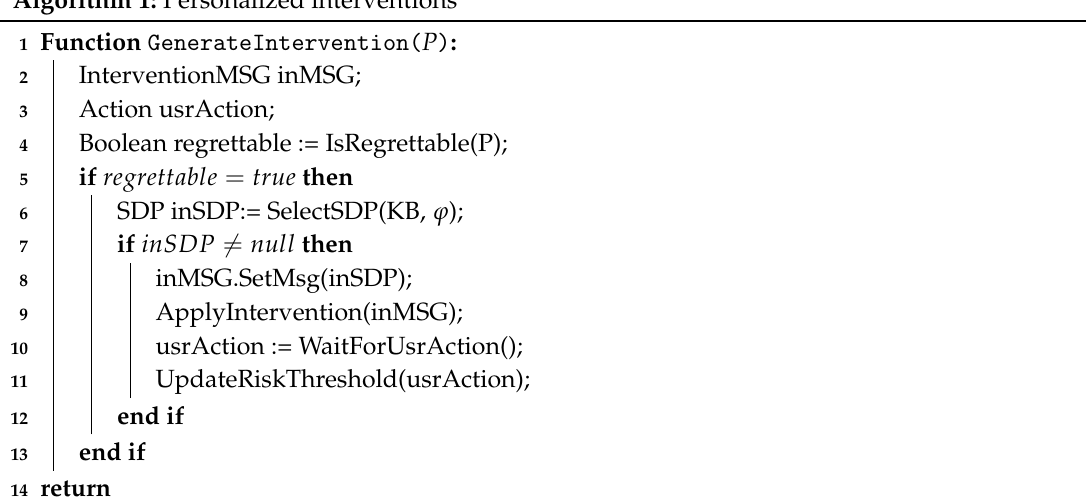
Algorithm 1: Personalized interventions